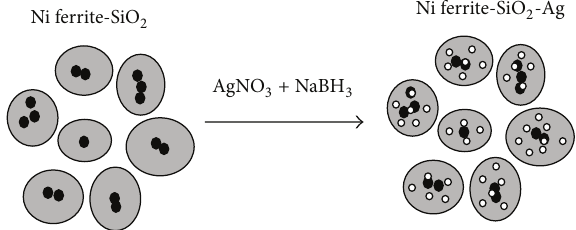
Figure 1: Incorporation of silver particles to silica coated nickel